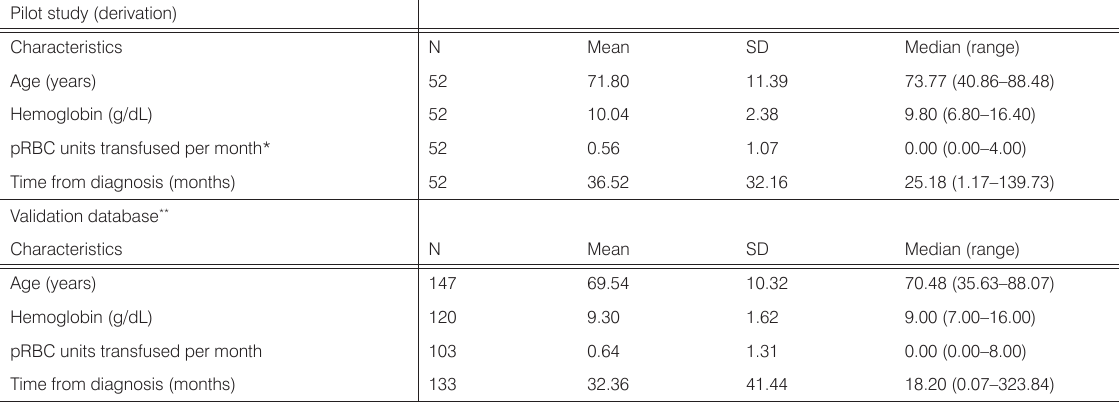
Table 2. Baseline characteristics from pilot study and validation database